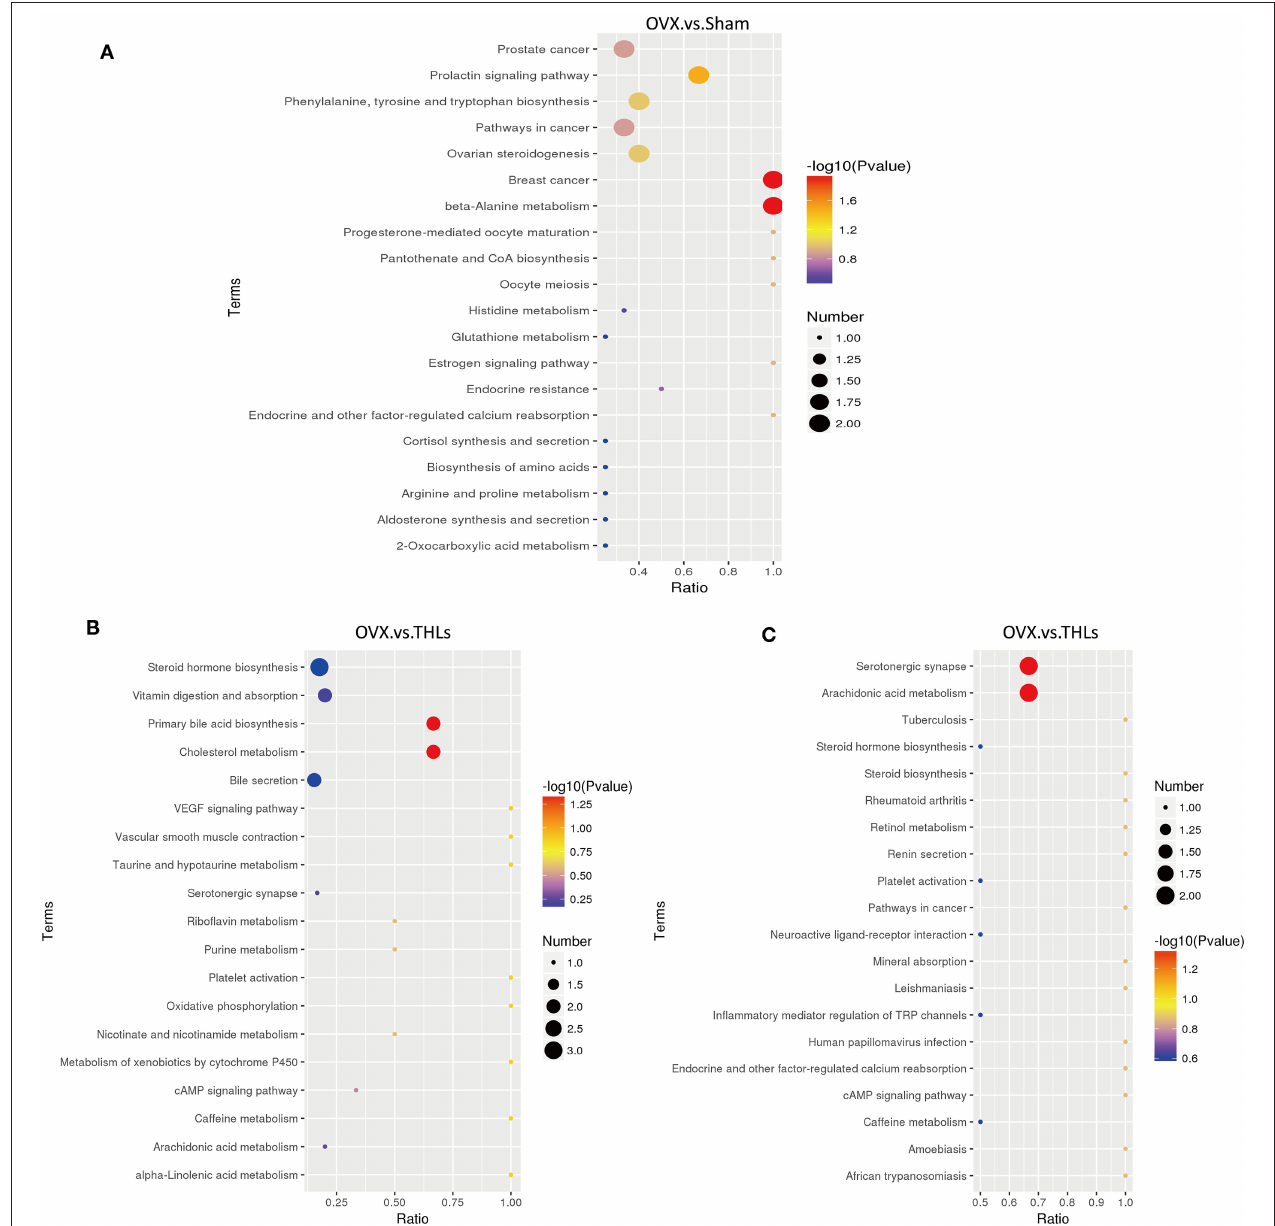
FIGURE 7 | KEGG enrichment bubble maps of differential metabolites: (A) OVX vs. Sham in the positive ion model; (B) OVX vs. THLs in the positive ion model; and (C) OVX vs. THLs in the negative ion model. The abscissa is the ratio of the number of the differential metabolites in metabolism pathway to the number of the all metabolites in the pathway, and greater ratio represents higher degree of enrichment. The color of bubble represents p -value, the smaller the p -value, the more reliable of the test. The size of bubble represents the number of differential